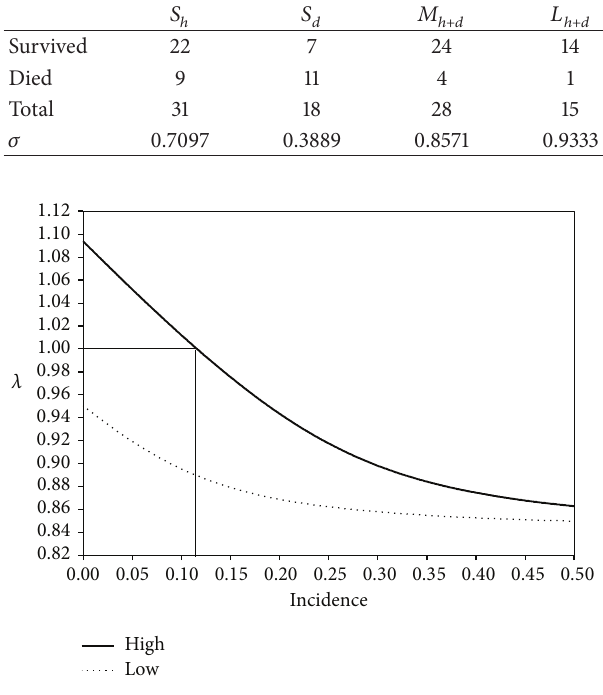
Figure 1: Asymptotic population growth rate ( 𝜆 ) in the sea fan Gorgonia ventalina as a function of disease incidence for high (1.3 recruits/year/adult colony) and low (0.19 recruits/year/adult colony) levels of recruitment. Incidence threshold for population viability ( 𝜆 ≥ 1.0 ) is